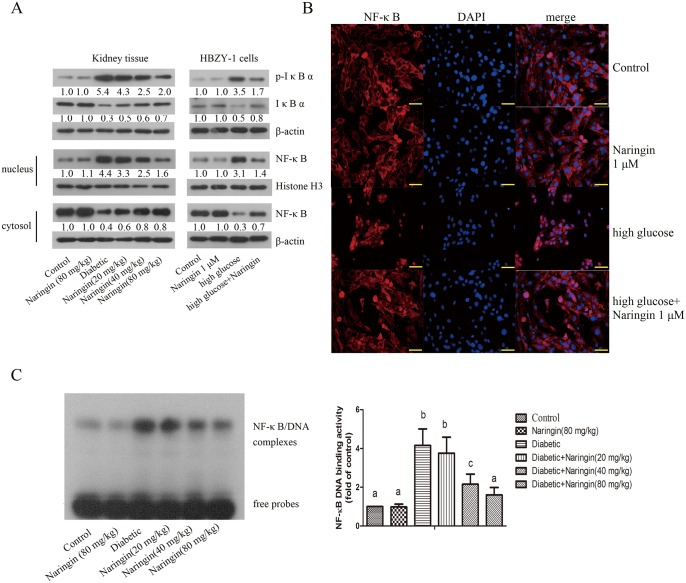
Naringin suppressed NF-κ B signaling pathway activation.(A) The protein levels of p-I κ B α, I κ B α and NF-κ B in kidney tissues and HBZY-1 cells were determined by western blot. Results represent three independent experiments. (B) The distribution change of NF-κ B in HBZY-1 cells was observed by immunofluorescence assay. Results represent three independent experiments. (C) The DNA binding activities of NF-κ B in kidney tissues were assessed by EMSA assay. Data were expressed as means ± SD, n = 5.a-c Means with different superscripts are significantly different (P< 0.05).